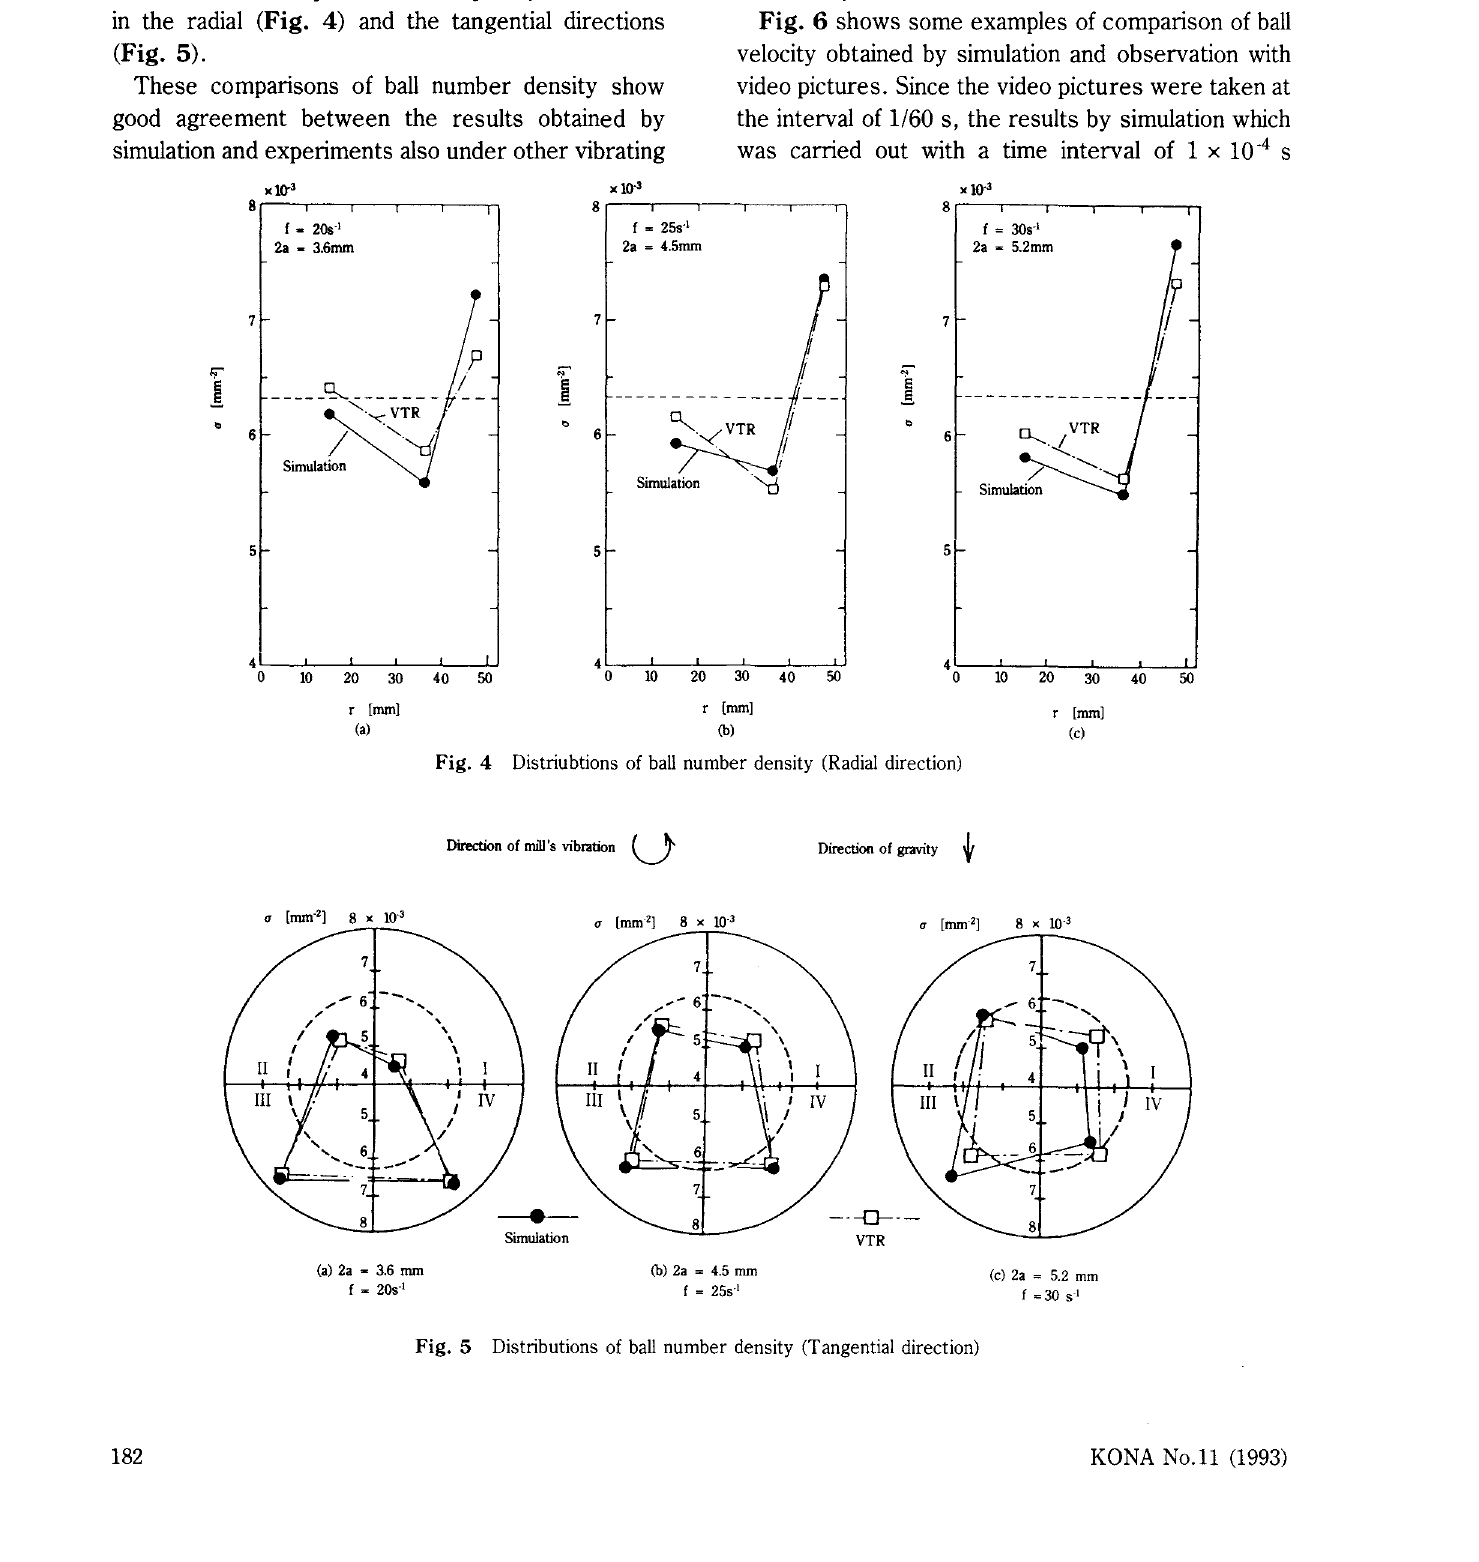
Fig. 5 Distributions of ball number density (Tangential